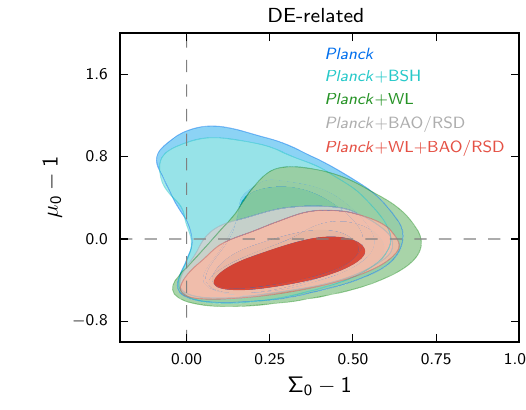
Fig. 6 Contour plots for marginalized posterior distributions for 68% and 95% C.L for the two parameters { μ − 1 ,η − 1 } at the present 0 0 time with no scale dependence. The time dependence is considered via the effective dark energy density parameter. Σ is obtained from Eq. (92).